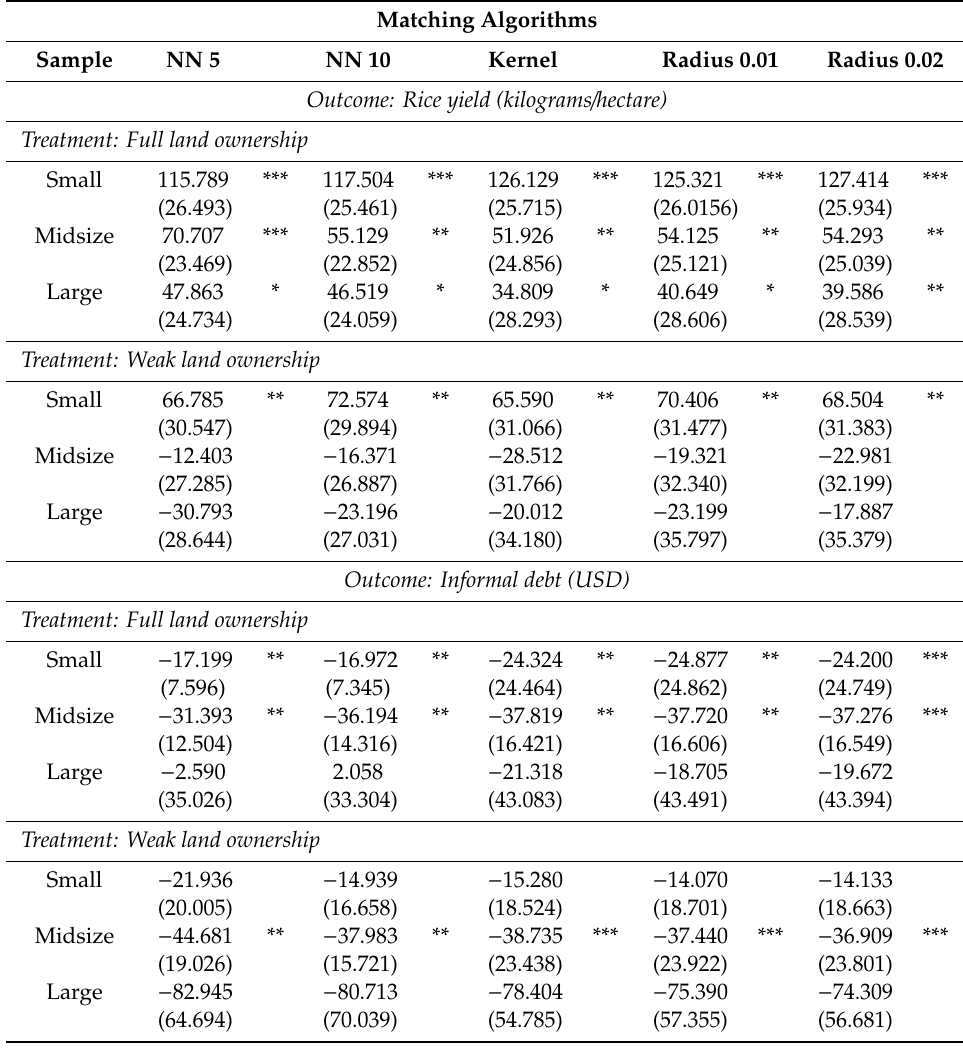
Table 6. Average treatment e ff ects (ATTs) of outcomes while using the trimming approach. Matching